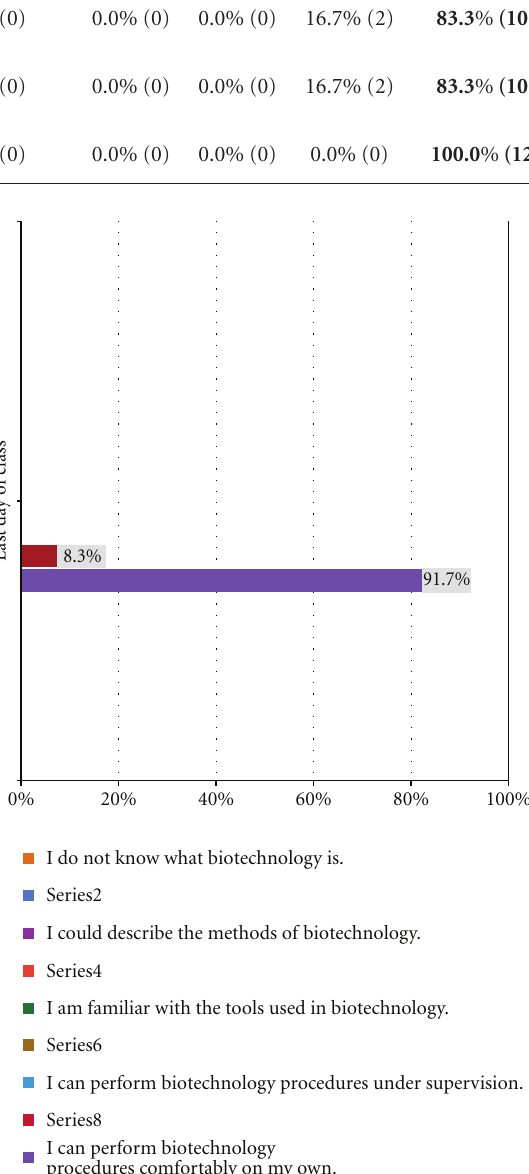
Figure 5: Survey Excerpt: Students’ perception of their own comfort with biotechnology on the last day of the class.